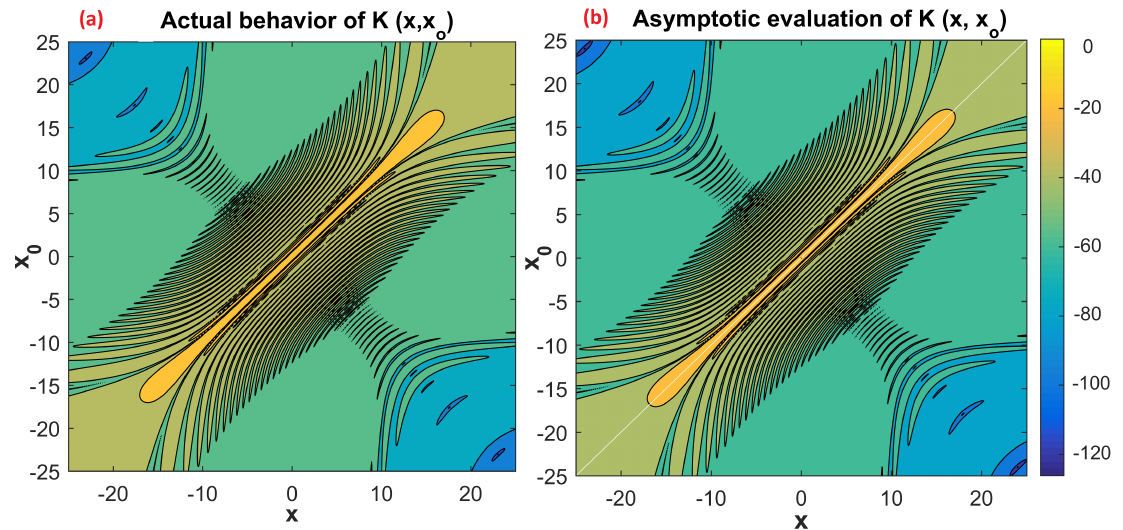
Figure 2. ( a ) Actual behavior of | K ( x , x o ) | obtained by computing the integral (6) numerically. ( b ) Behavior of | K ( x , x o ) | provided by the asymptotic evaluation. Both the diagrams are sketched in